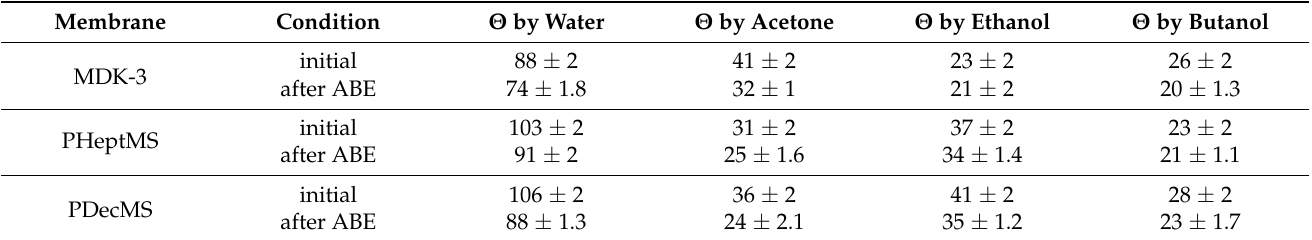
Table 3. Contact wetting angles of the membranes before and after exposure to the ABE-fermentation broth ( θ , ◦